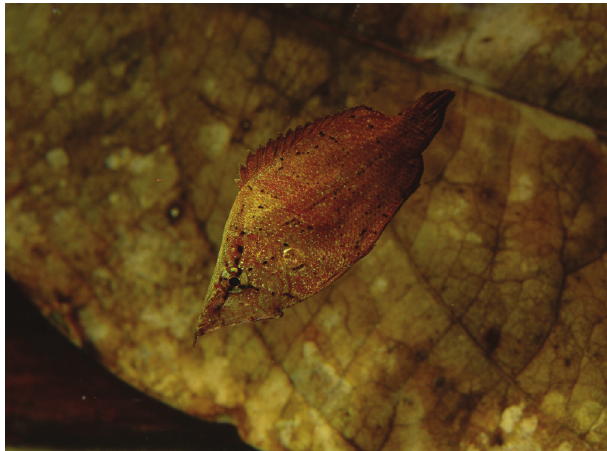
Fig. 1. A freshly collected leaf fish Monocirrhus polyacanthus . Photo by F. P.